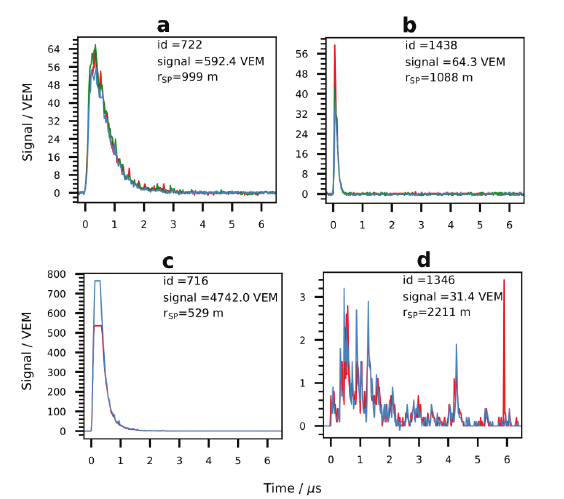
Figure 6. Some typical calibrated FADC traces of the WCDs. The di ff erent colors indicate the signals from the photomultipli- ers in each detector. In detectors #716 and #1346 two of the three photomultipliers were